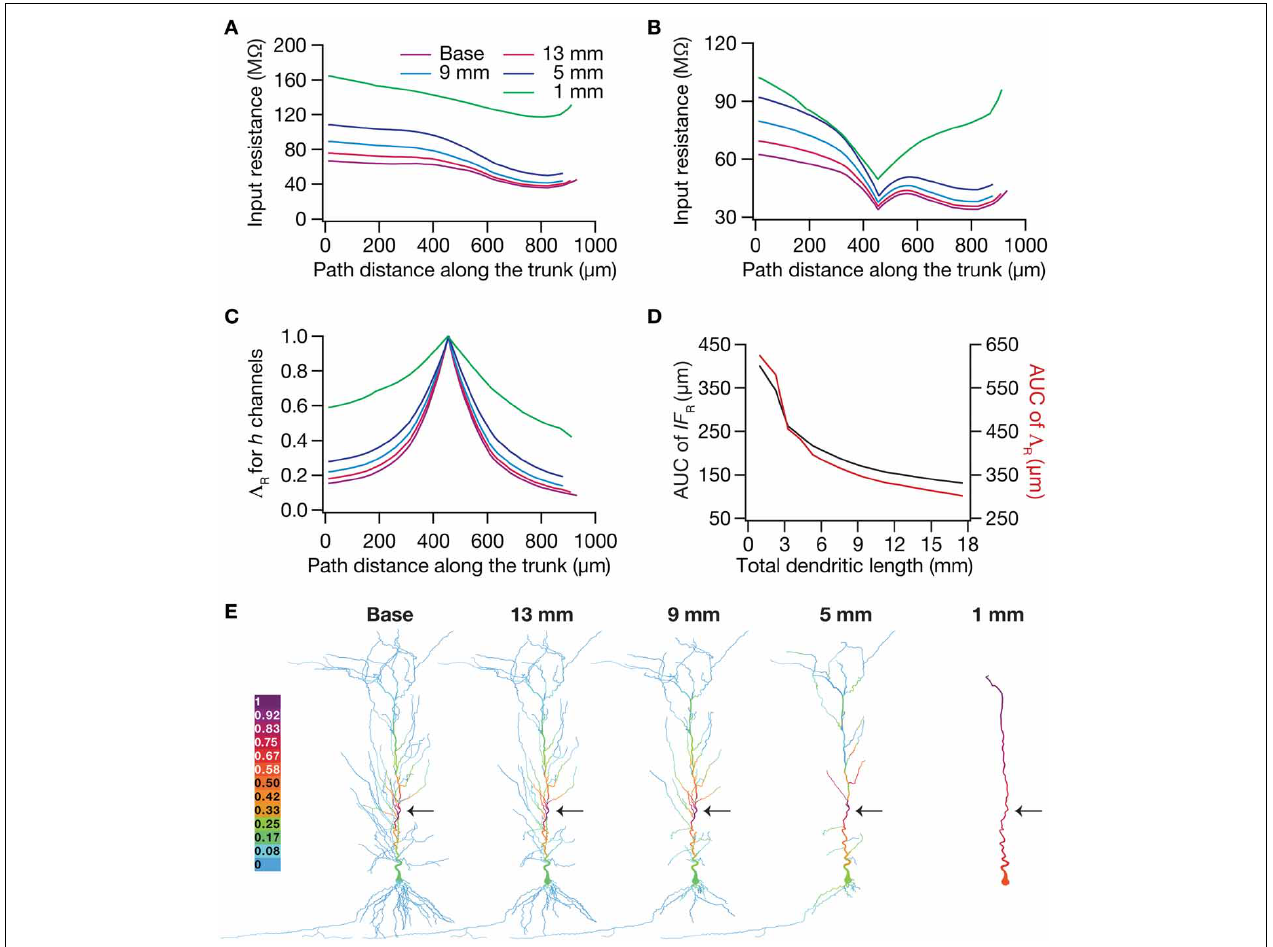
field for R in , along the somato-apical trunk for different morphologies. (D) Area under curve (AUC) for unnormalized (black) and normalized (red) influence field, plotted as functions of dendritic length of the neuronal morphology under consideration. (E) Color-coded influence field across the entire dendritic arbor showing the effect of a single HCN-channel cluster located (black arrow) at ∼ 450 μ m from soma on R in for various